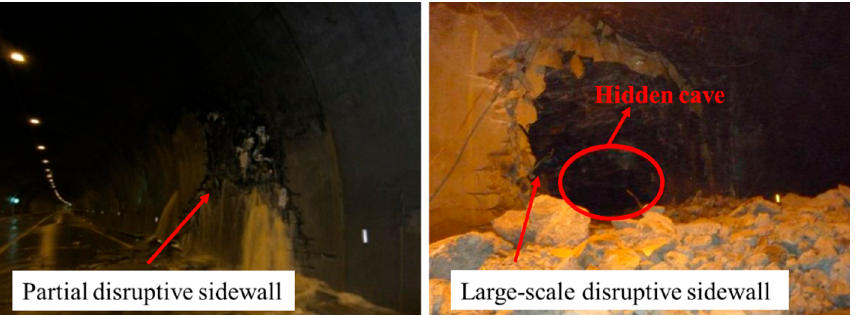
Figure 4. Disruption phenomenon of secondary